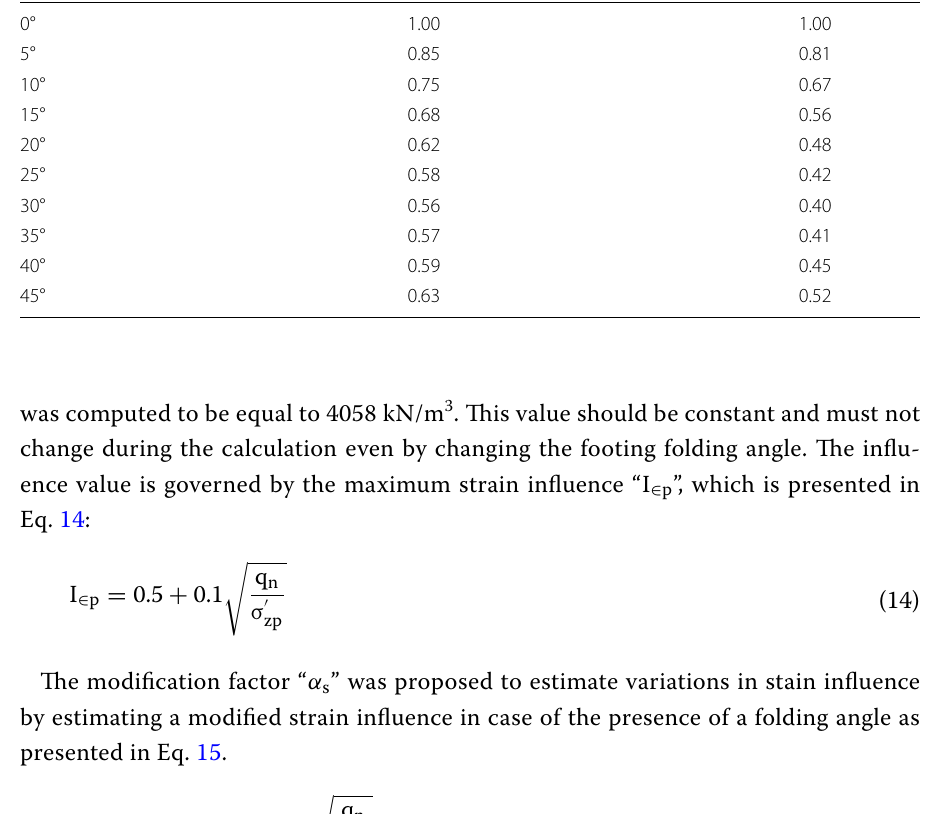
Table 3 Settlement modification factor for different folding angles Folding